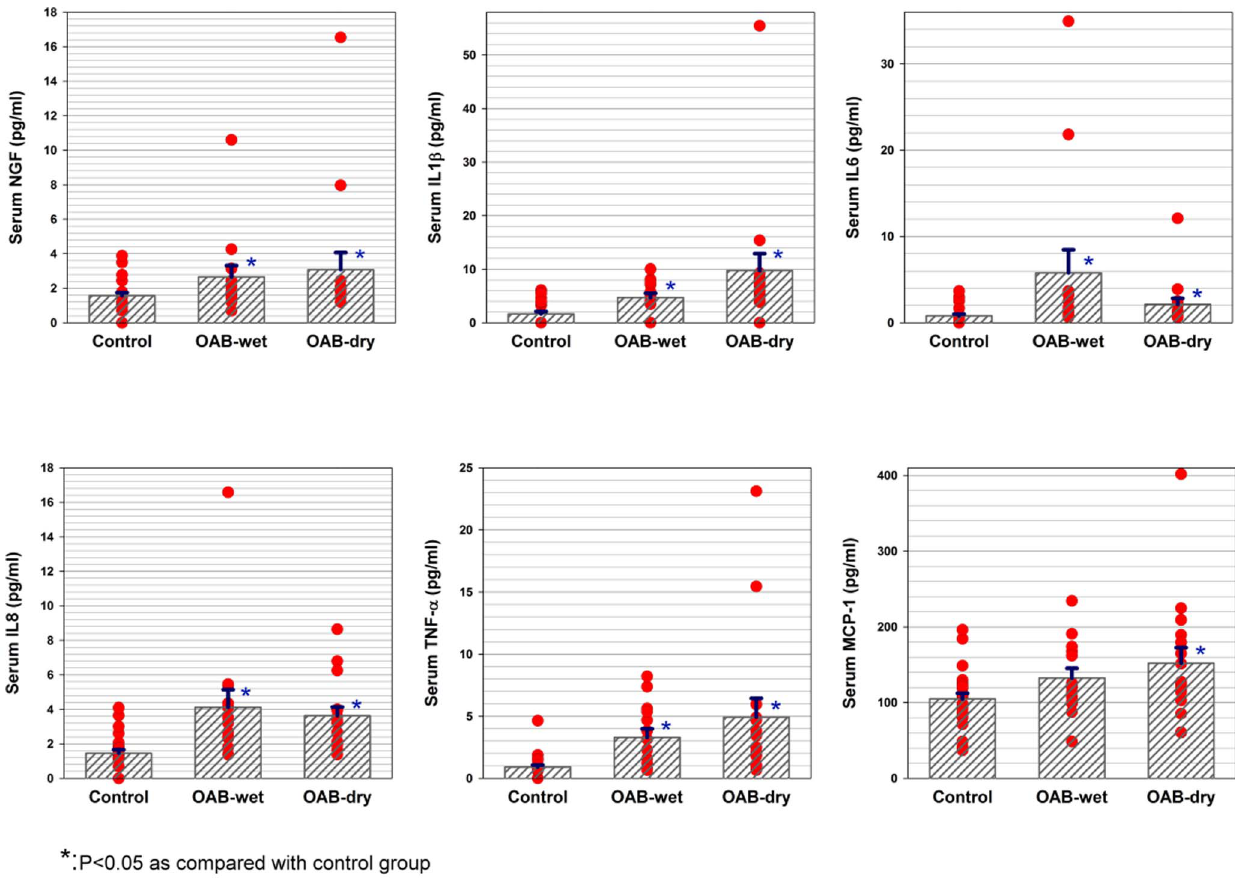
Figure 1. The scattered plots of serum nerve growth factor, interleukin (IL) -1 b , IL-6, IL-8, tumor necrosis factor (TNF) - a , and monocyte chemotactic protein (MCP)-1 among the controls, OAB-dry and OAB-wet patients.